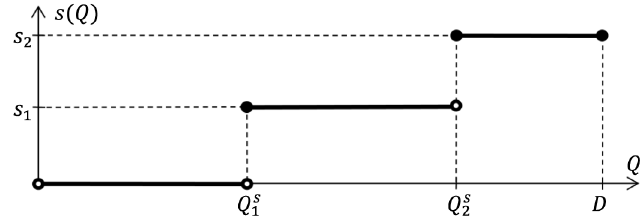
Figure 3. Step function of the discount s ( Q ) on stored